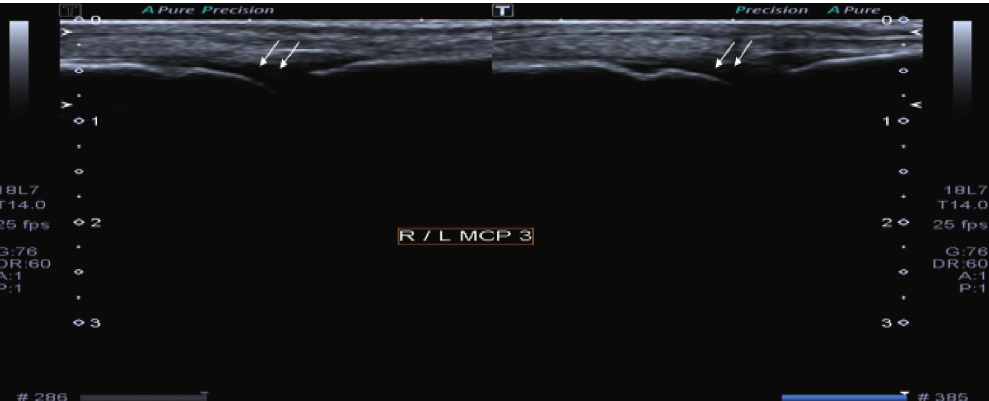
Figure 11: Grayscale images of 3 rd metacarpophalangeal joint demonstrating moderate synovial thickening. The findings are consistent with Grade 2 synovitis (white